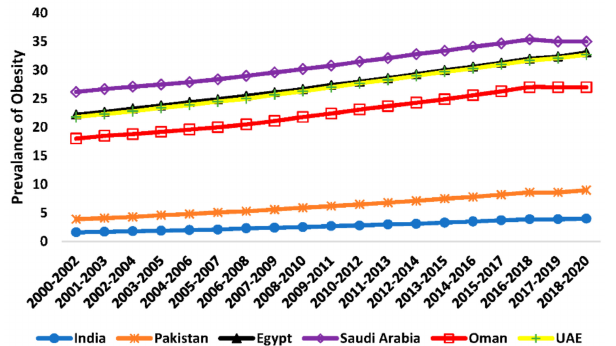
Figure 2. Prevalence of obesity in the six countries (India, Pakistan, Egypt, Saudi Arabia, and United Arab Emirates)